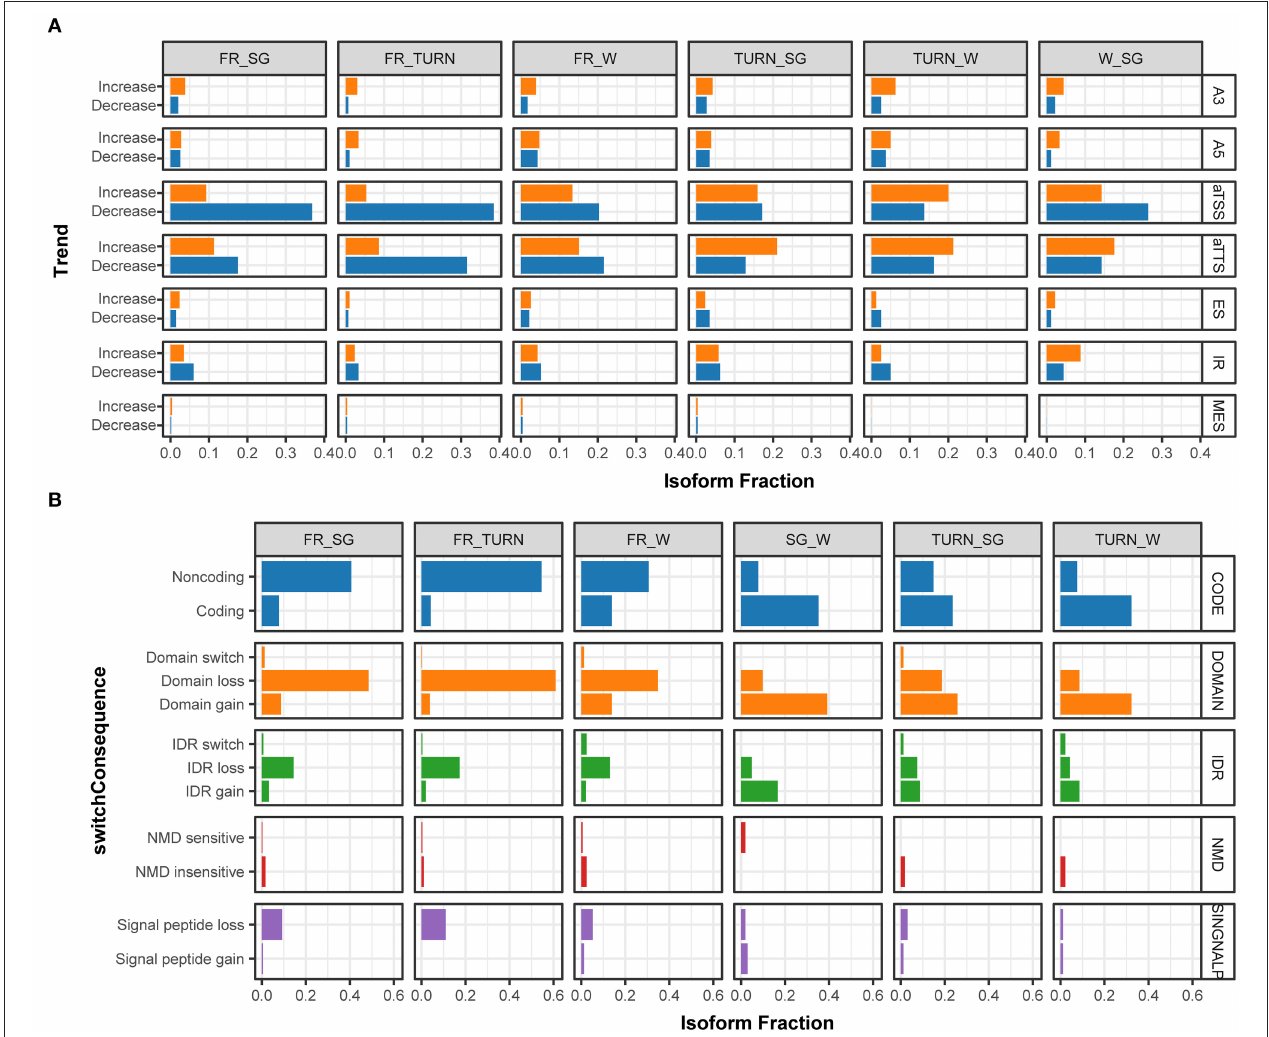
FIGURE 4 | The fraction of isoforms with significant usage switching associated to aTSS, aTTS, and AS events along with the fruit development and the predicted functional consequences. (A) The fraction of isoforms that significantly changed their usage (increasing, colored in orange; and decreasing, colored with light blue) in the pairwise comparison among the four stages. Isoforms derived from alternative 3’ acceptor site (A3), alternative 5’ donor site (A5), alternative transcription start site (aTSS), alternative transcription termination site (aTTS), exon skipping (ES), intron retention (IR), and multiple exon skipping (MES) were summarized separately in the IsoformSwitchAnalyzeR package. (B) The percentage of isoforms associated with functional changes ascribed to isoform switching events in the pairwise comparison of expression among the investigated developmental stages. The functional consequences of isoform switches were based on the annotation of coding potential (CODE, predicted by using CPC2), protein domain change (DOMAIN, predicted by PfamScan), intrinsically disordered regions (IDR, via IUPred2A), sensitivity to Non-sense Mediated Decay (NMD, when harboring premature termination codons), and signal peptide